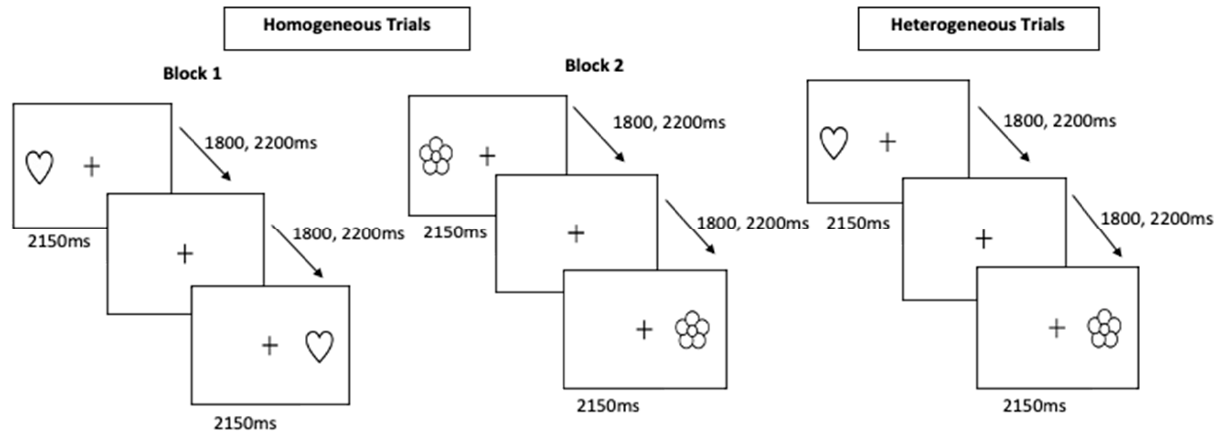
Figure 1. Depiction of the homogeneous and heterogeneous trials of the hearts and flowers task.